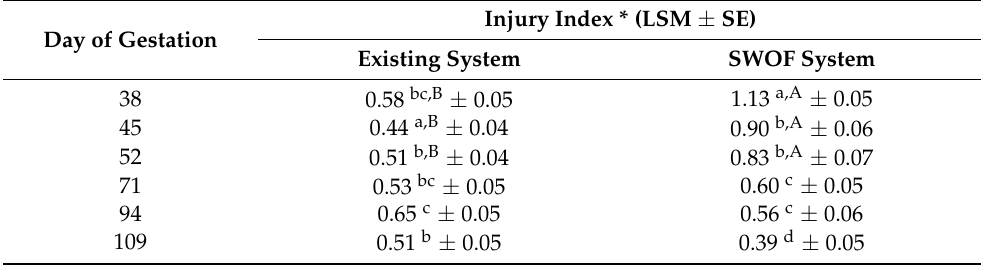
Table 6. Sows’ injury index (LSM ± SE) during gestation in the existing and SWOF systems.